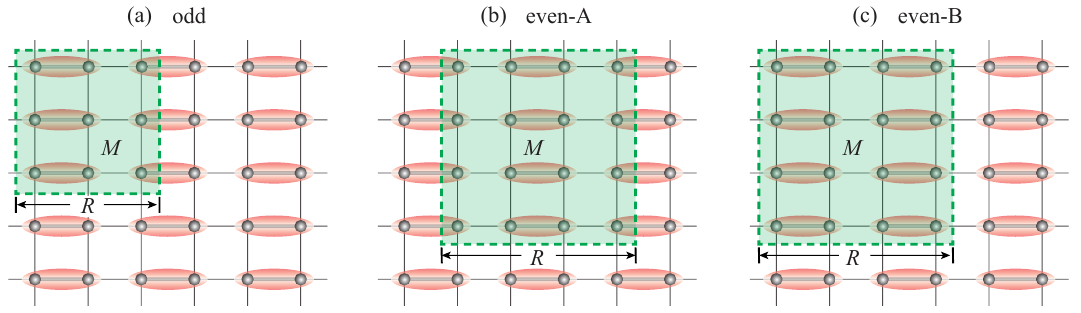
Figure 5: The q = [ Q / ( J + Q )] dependence of JQ (c) with L = 8,16,32,64,128 and 256. All the crossings of two sizes L and 2 L for ρ L , R and R are presented in (d). The curves are fitting function in Eq. (8) with s s d = 0.59862 ( 5 ) for ρ = 0.59863 ( 5 ) for R q L , q c s c